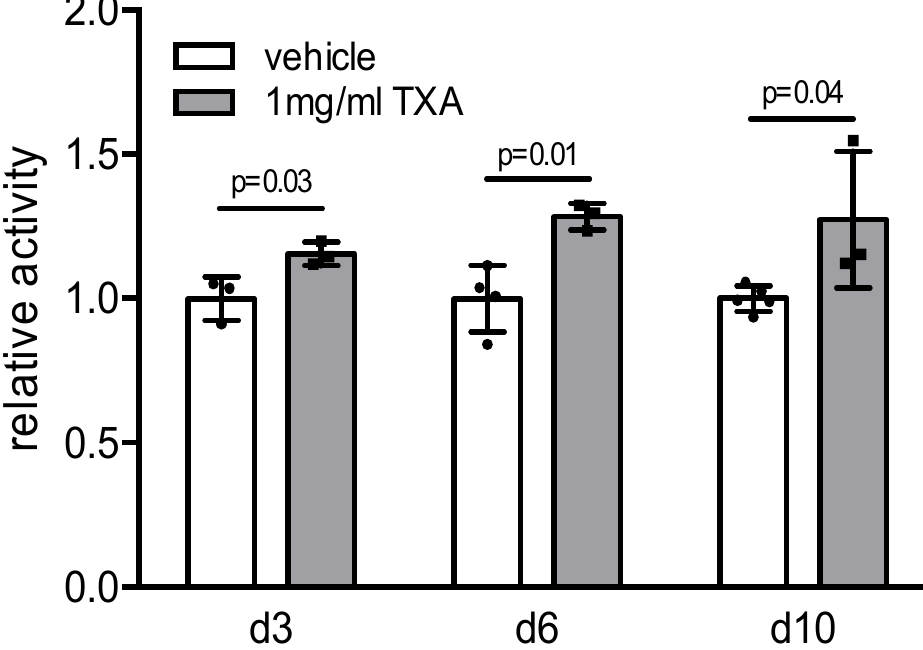
Figure 3. TXA enhances cell proliferation of bone marrow-derived osteoblasts. MTT proliferation assay of bone marrow-derived osteoblasts stimulated with 1 mg/mL TXA for 6 h at the indicated time points; n = 3–5 independent cultures per group were used. Data presented are means ± SD. As bone resorption represents an essential mechanism to maintain bone quality through removal of damaged or aged bone tissue, we next cultured bone marrow cells undergoing osteoclast differentiation with continuous TXA exposure. Here, we detected a striking reduction in osteoclast formation at all concentrations tested (Figure 4a). This effect was also observed when bone marrow cells were treated only once with TXA at the beginning of osteoclast differentiation, indicating that the inhibitory effect of TXA on osteoclastogenesis affects early osteoclast formation (Figure 4b). In contrast, stimulation of osteoclast cultures with TXA for 24 h did not affect osteoclast numbers at day 7 of differentiation (Figure 4c). Likewise, stimulation of osteoclast cultures with TXA for 6 h caused no alteration in cell viability as assessed by MTT assay (Figure